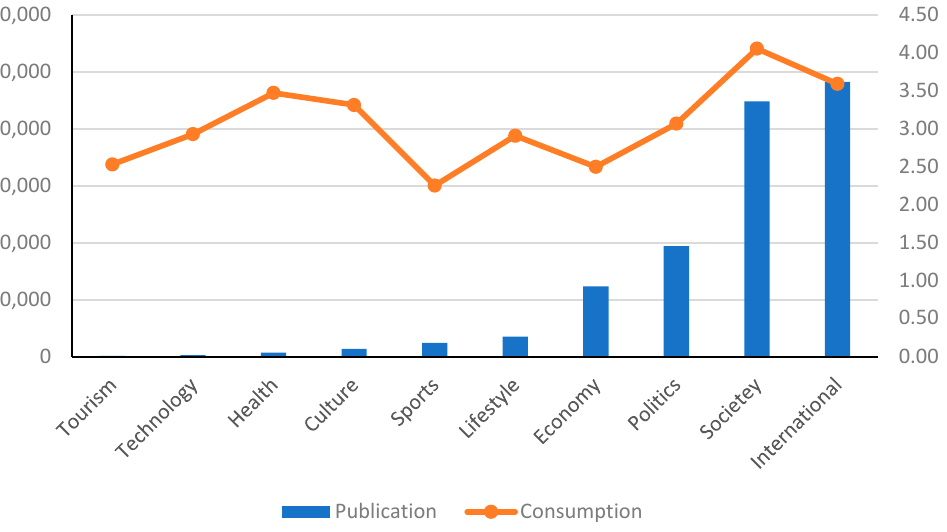
Figure 3. Comparison of the average number of published articles and reported audience’s interest in various news articles’ categories.